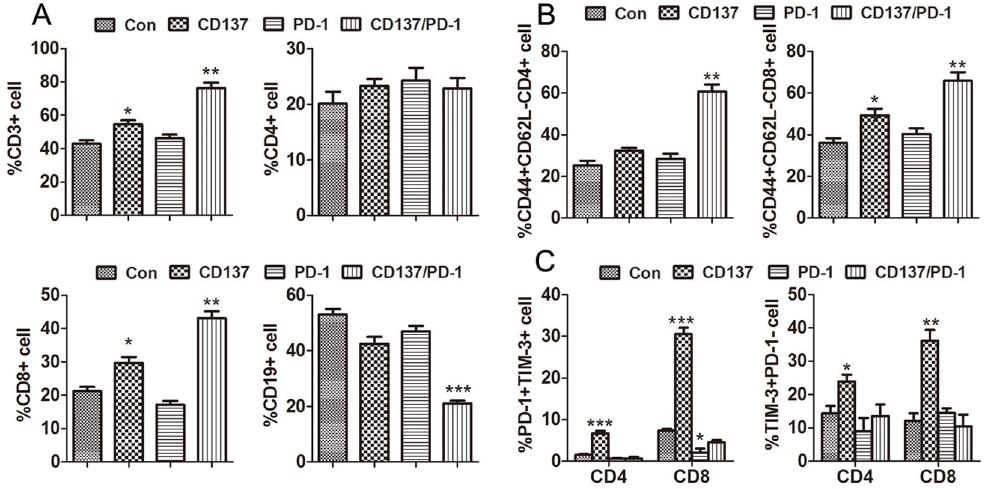
Figure 5. Analysis of peritoneal lymphocyte subsets from mice injected with the anti-PD-1/CD137 combination. Mice (3/ group) transplanted i.p. with 3 × 10 6 ID8 cells 10 day earlier were injected i.p. twice at 4 days interval with 0.5 mg of control, anti- CD137, anti-PD-1 or anti-PD-1/CD137 mAb. Two weeks later, peritoneal lavage from treated mice was analyzed by flow cytometry for the percentage and phenotype of peritoneal lymphocytes. The percentages of CD3 + , CD4 + , CD8 + and CD19 + lymphocytes in peritoneal lavage and CD44 + CD62L - effector/memory cells in CD4 + and CD8 + T cells are shown in (A) and (B) respectively. The percentage of PD-1 + TIM-3 + and PD-1 - TIM-3 + cells in peritoneal CD4 + and CD8 + T cells are shown in (C) with representative dotplots in Figure S2. Data are presented as M±SEM from 3 mice of each group and are representative of 2 independent experiments. *P < 0.05, **P < 0.01, ***P < 0.001, PD-1 or CD137 mAb compared with control mAb, PD-1/CD137 mAb compared with control and single